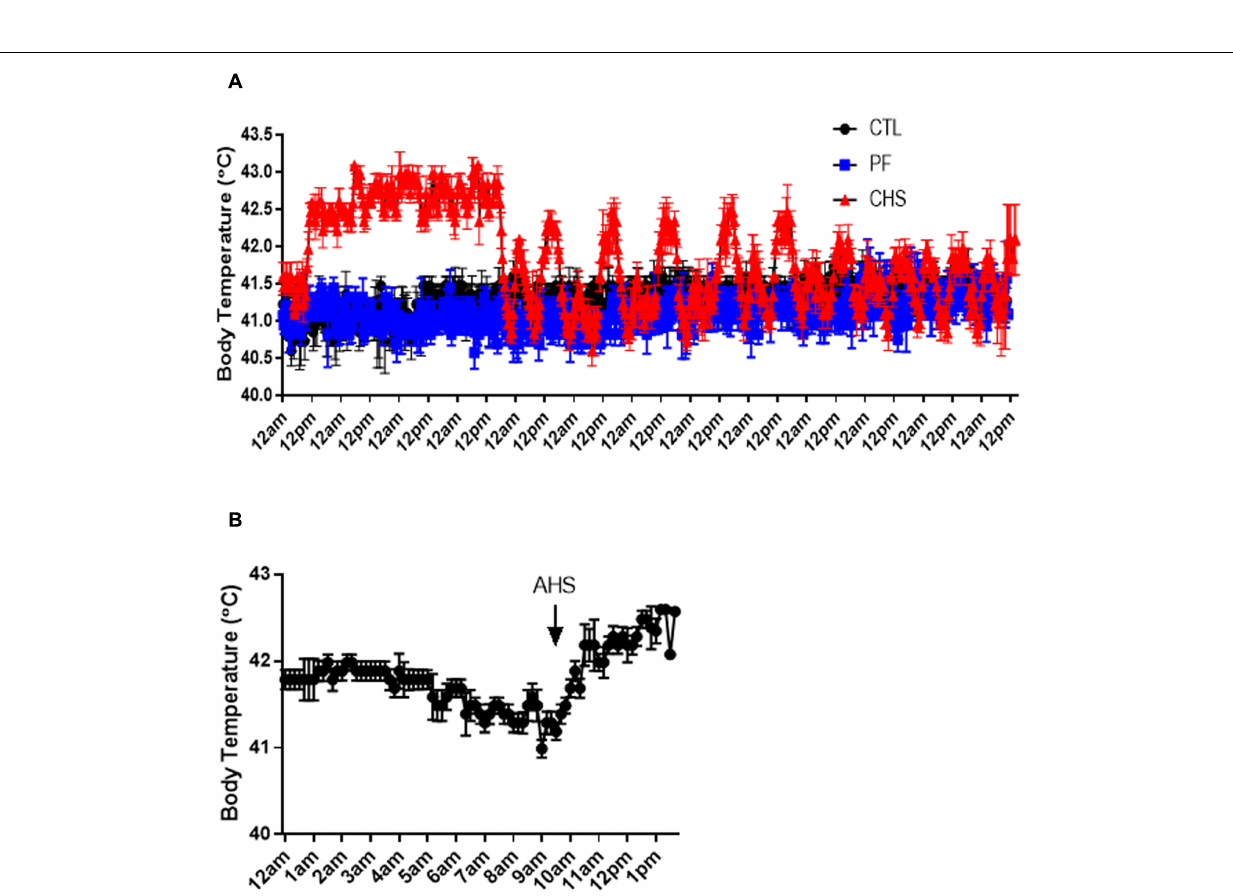
Frontiers in Physiology |